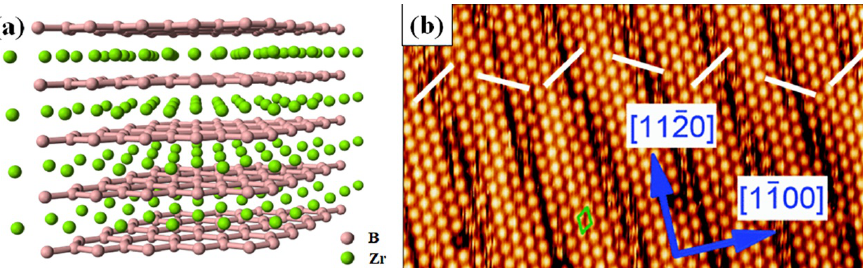
Fig. 2 Hexagonal close-packed structure (a) and STM image (b) of the (2×2)-reconstructed ZrB 2 (0001) surface. Reproduced with permission from Ref. [66], © The American Physical Society